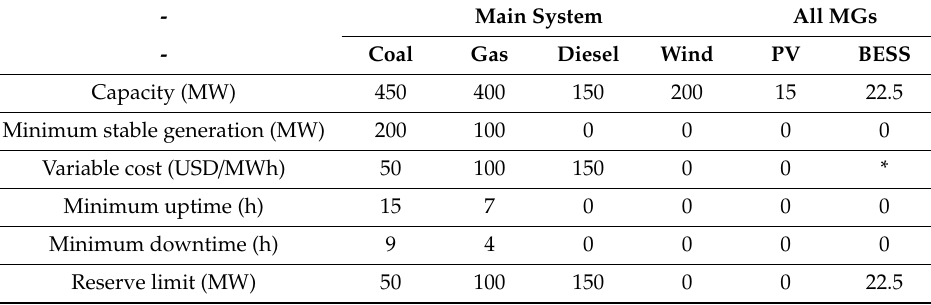
Figure 2. Illustration of the system under study, comprising 50 microgrids (MGs). Table 2. Generation units’ parameters, including those of all aggregated